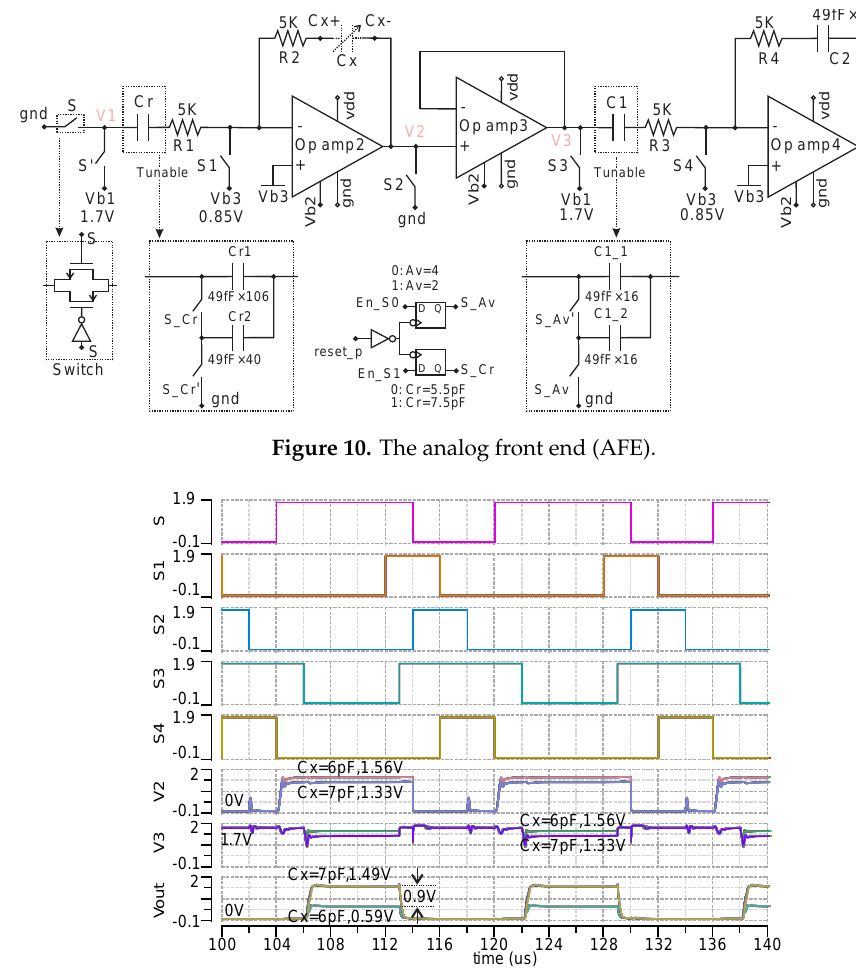
Figure 11. Post layout simulation of AFE over a −40 to 120 °C temperature range with 1.8 V supply, Cref = 5.5 pF and Av = 4. Results show that the Vout changes approximately 900 mV for a 6 to 7 pF capacitance range. Temperature dependence is low due to the use of the BGR bias source and SC sampling method.